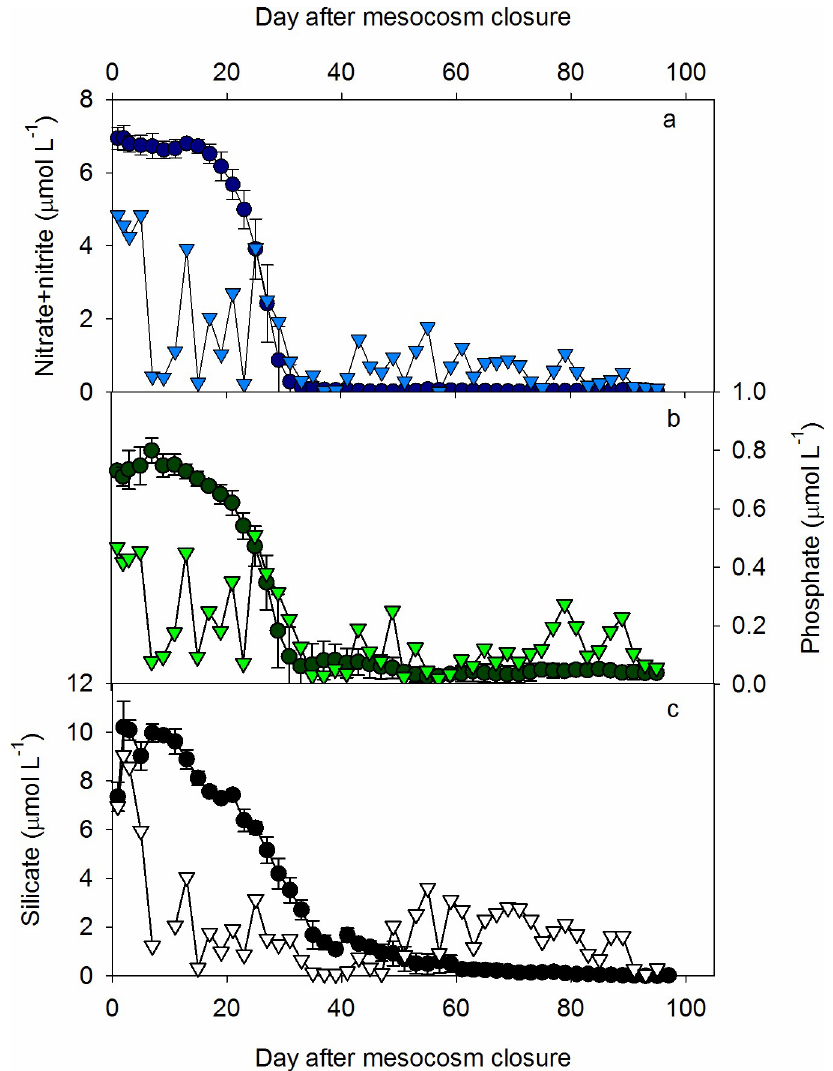
Fig 2. Average nutrient concentrations from a depth integrated water sampler (0–18 m). (a) nitrate + nitrite, (b) phosphateand (c) silicate in the mesocosms (circles) and adjacent fjord (triangles)throughoutthe experiment. Valuesfor mesocosms are expressedas the average ± standard deviation(n =